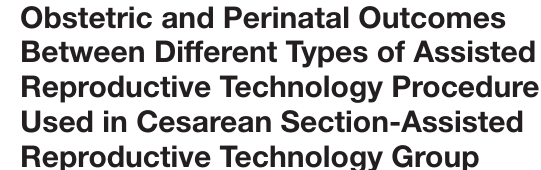
whom were in CS–SC group, whereas none of the women with previous VD had uterine rupture. An overwhelming majority ( > 90%) of women with previous CS had subsequent CS delivery, regardless of conception method and birth